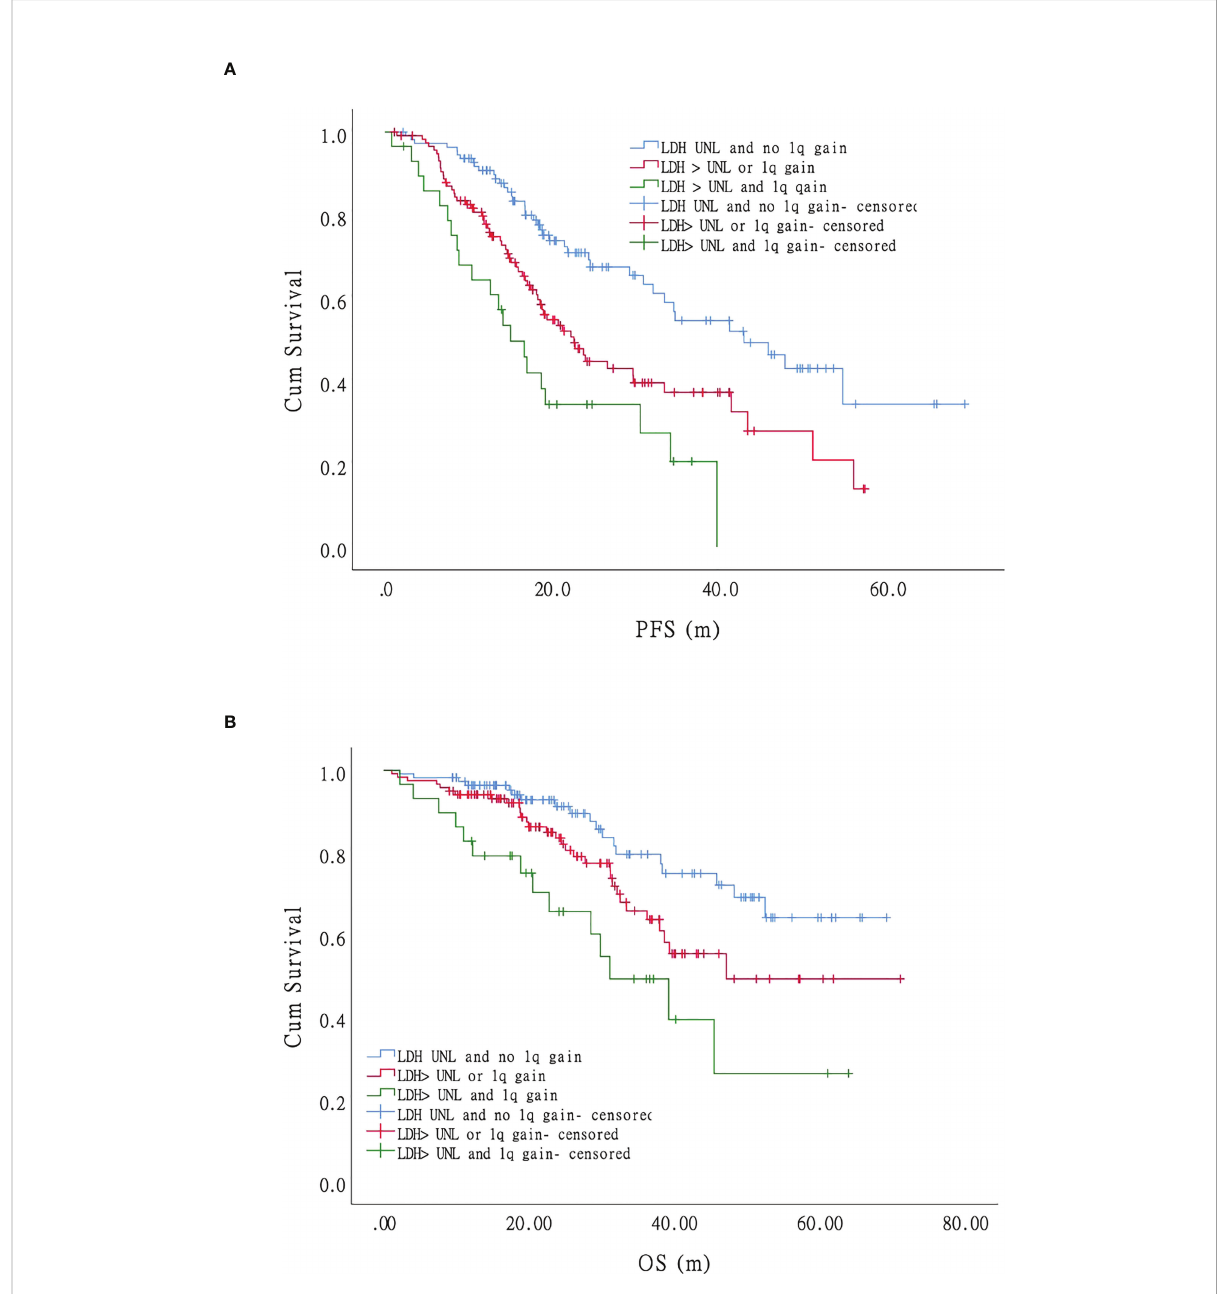
FIGURE 5 Impact of LDH on progression-free survival (PFS) and overall survival (OS) of patients with myeloma: LDH and 1q gain have an adverse effect on the survival (both PFS and OS) of MM patients independently. Patients with co-occurrence of LDH>UNL and 1q gain (the green curve) had the worst survival while those without LDH nor 1q abnormal (the blue curve) had the most favorable survival. Patients with LDH>UNL or 1q gain (the red curve) showed intermediate compared with patients mentioned above. (A) . Progression-free survival. (B) . Overall